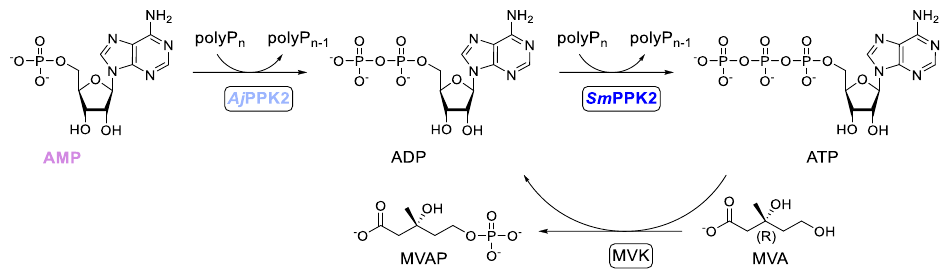
Figure 1. Enzyme cascade for adenosine triphosphate (ATP) production and regeneration and mevalonate phosphate (MVAP) production. Two polyphosphate kinases (PPKs) phosphorylate adenosine monophosphate (AMP) to ATP with polyphosphate (polyP) as phosphate donor. ATP is consumed by mevalonate kinase (MVK) to convert mevalonate (MVA) to MVAP.